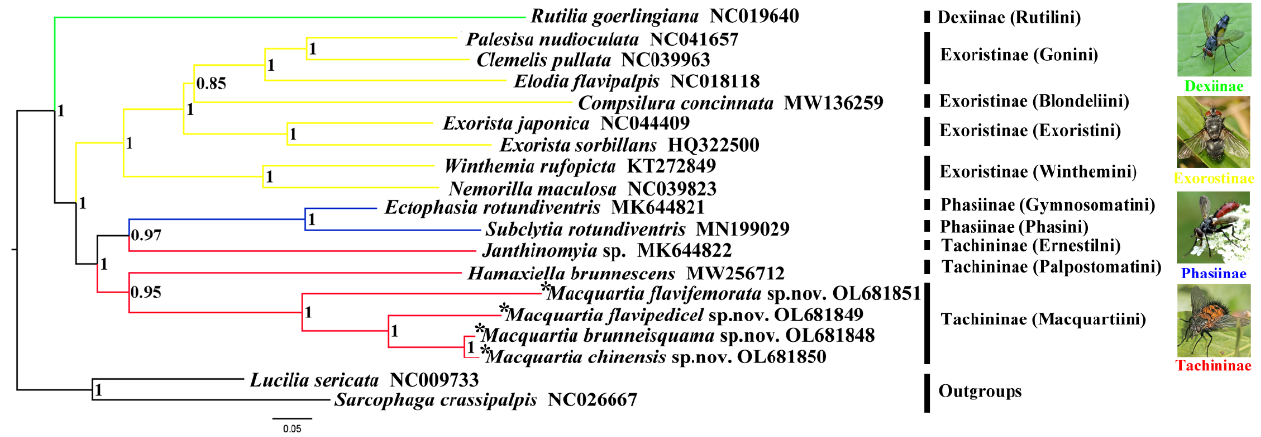
Figure 11. BI phylogenetic tree of nineteen species which consist of seventeen Tachinidae species and two outgroups. * Species documented in this